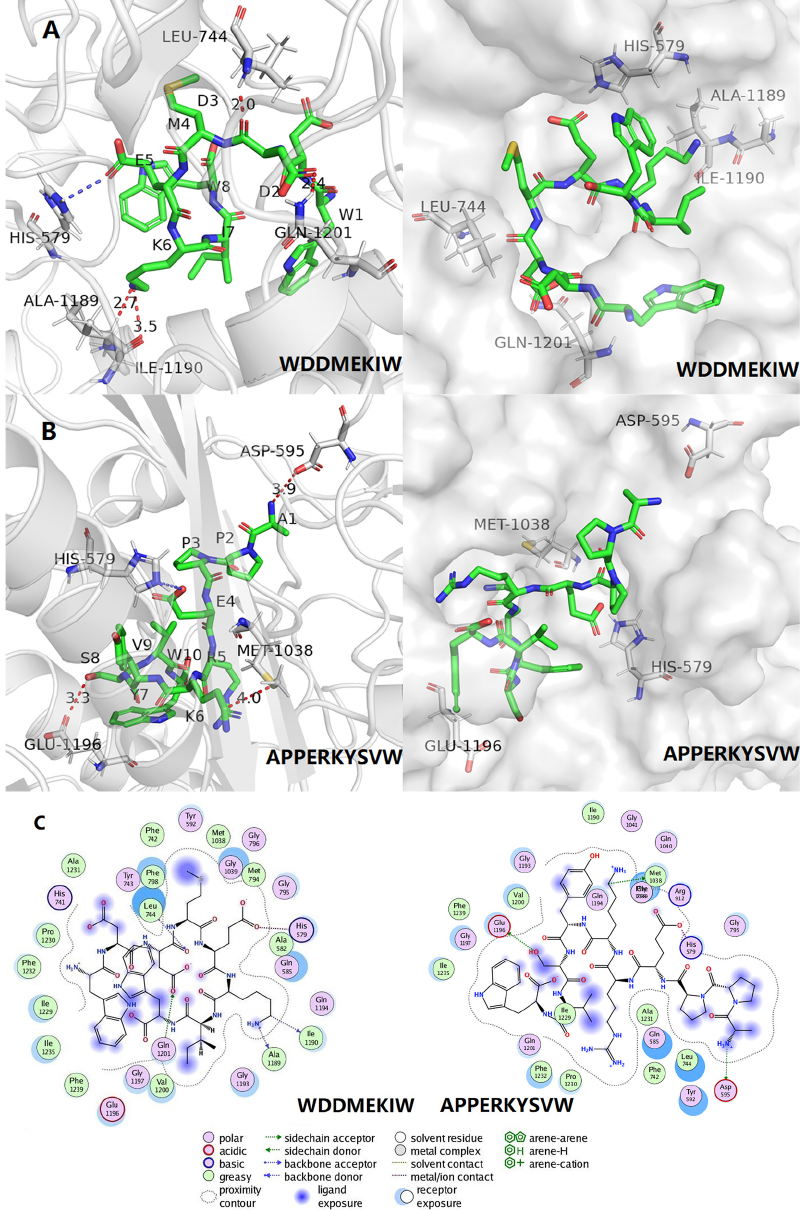
Figure 5. The molecular docking analysis of the synthesized peptides with xanthine oxidase (XO). ( A ) Molecular docking of the peptide WDDMEKIW with XO. ( B ) Molecular docking of the peptide APPERKYSVW with XO. ( C ) The binding and interaction visualization of peptides with XO. Table 4. The interaction types and amino acid residues of peptides with XO.